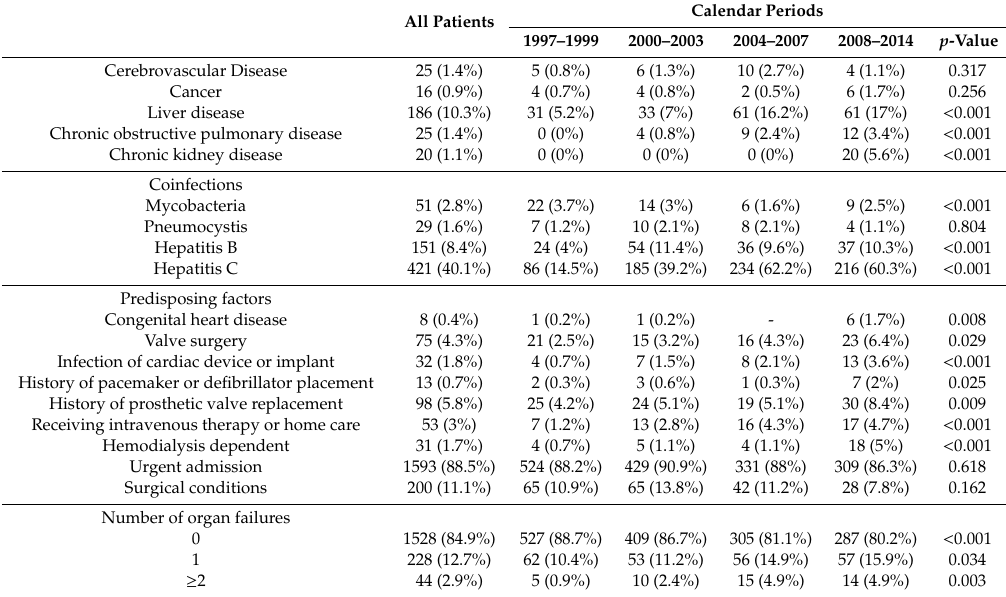
Figure 3. Epidemiological trends of causative microorganisms of infective endocarditis in HIV- infected patients in Spain (1997 to 2014). ( A ) Staphylococcus aureus . ( B ) Coagulase-Negative staphylococci. ( C ) Streptococci. ( D ) Gram-negative bacilli. ( E ) Enterococci. ( F ) Fungus. Statistical: Differences between groups were calculated by the Chi Square test. Linear trends from 1997–1999 to 2008–2014 calculated by the Extended Mantel – Haenszel Chi Square.